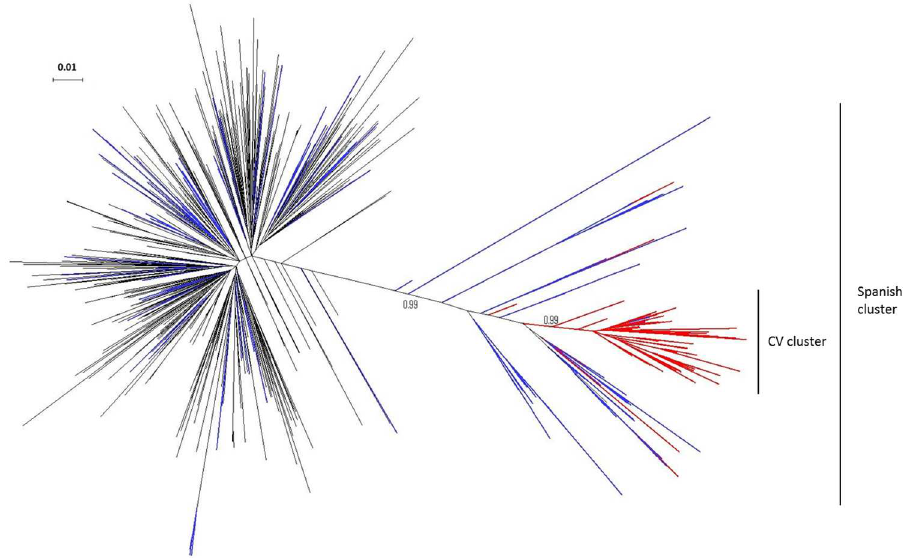
Fig 3. Maximum likelihood tree of the CV-cluster. It includessequencesfrom the city of Valencia(red), from other Spanishcities (blue) and sequencesfrom other countries retrieved by BLAST analysis(grey). aLRT support values defining the CV-cluster (n = 113) and the larger Spanishclade it derives from (n = 194) are shown.